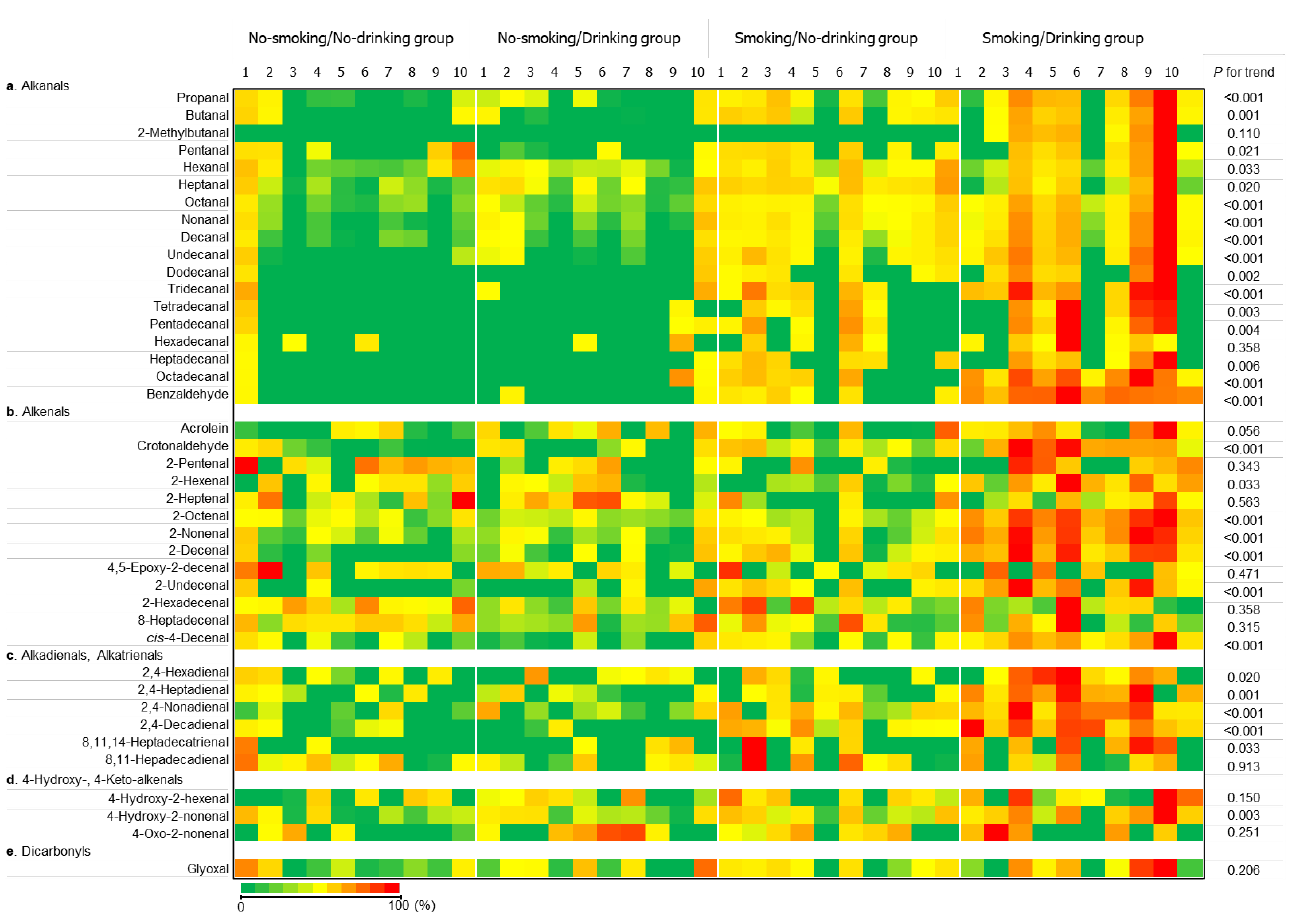
Figure 2. Heat map of the levels of reactive carbonyl species (RCS) in the individual subjects in the present study. Green color cells indicate that RCS was not detected in the plasma samples. The maximum levels of each RCS are colored red.